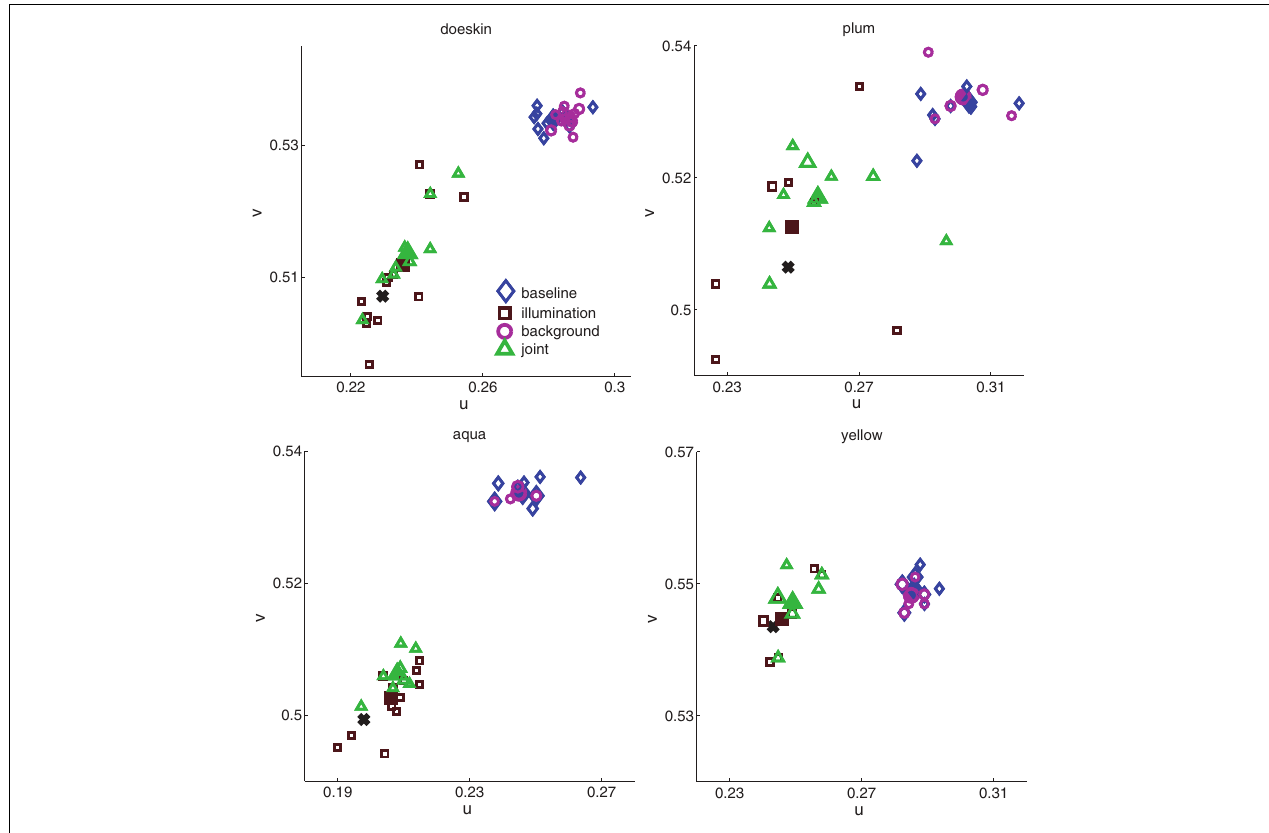
FIGURE 4 | Color matches in all four conditions (baseline, blue diamonds; background, magenta circles; illumination, brown squares; joint, green triangles) for four of the sixteen cubes. Each unfilled data point represents one paint chip chosen; the size of the data point represents